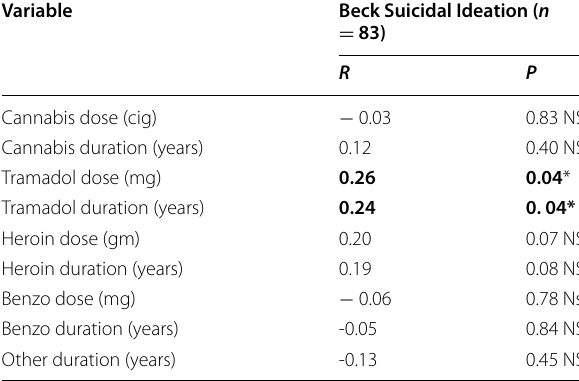
Table 8 Correlation between Beck Suicidal Ideation and different parameters of other substances of abuse among the studied group